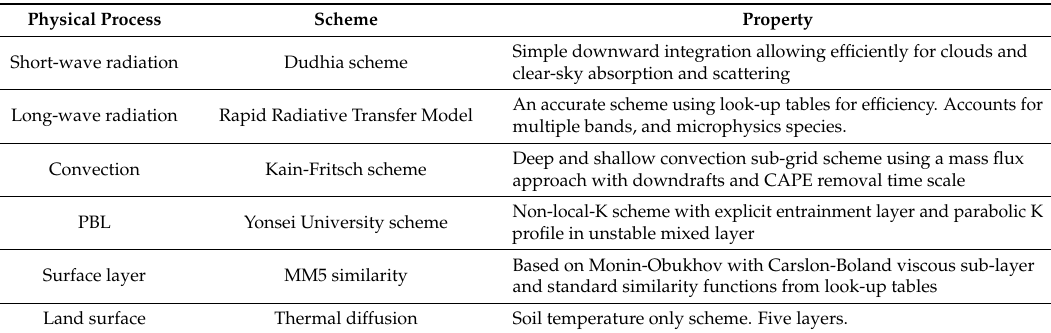
Table 1. Physical schemes used in the WRF